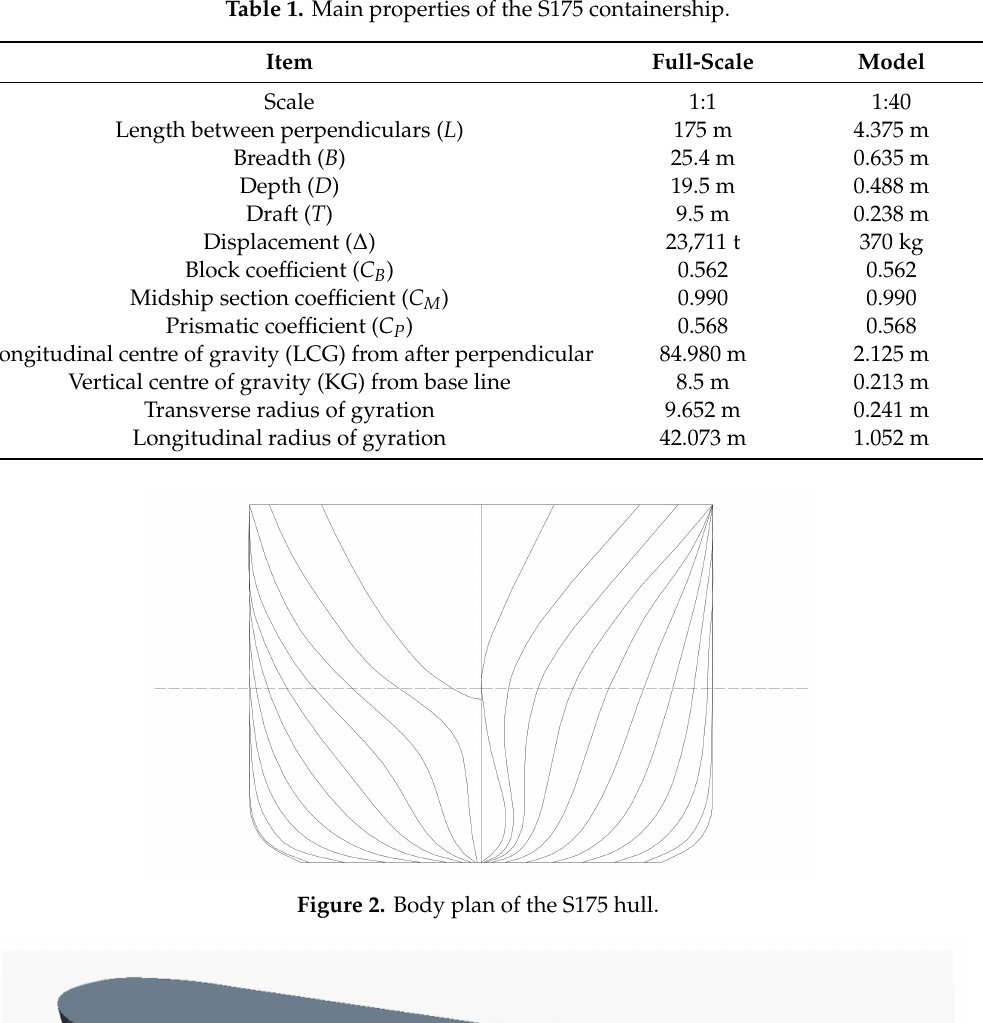
Table 1. Main properties of the S175 containership.